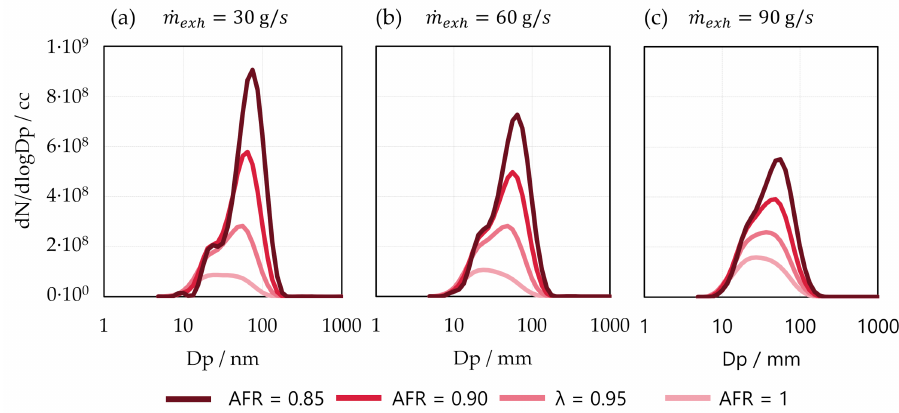
Figure 6. Spectral density curves, obtained at the burner test bench, at T exh = 600 ◦ C and considering AFR variations at various constant exhaust mass flow rates: ( a ) . m exh = 90 g ( c ) s